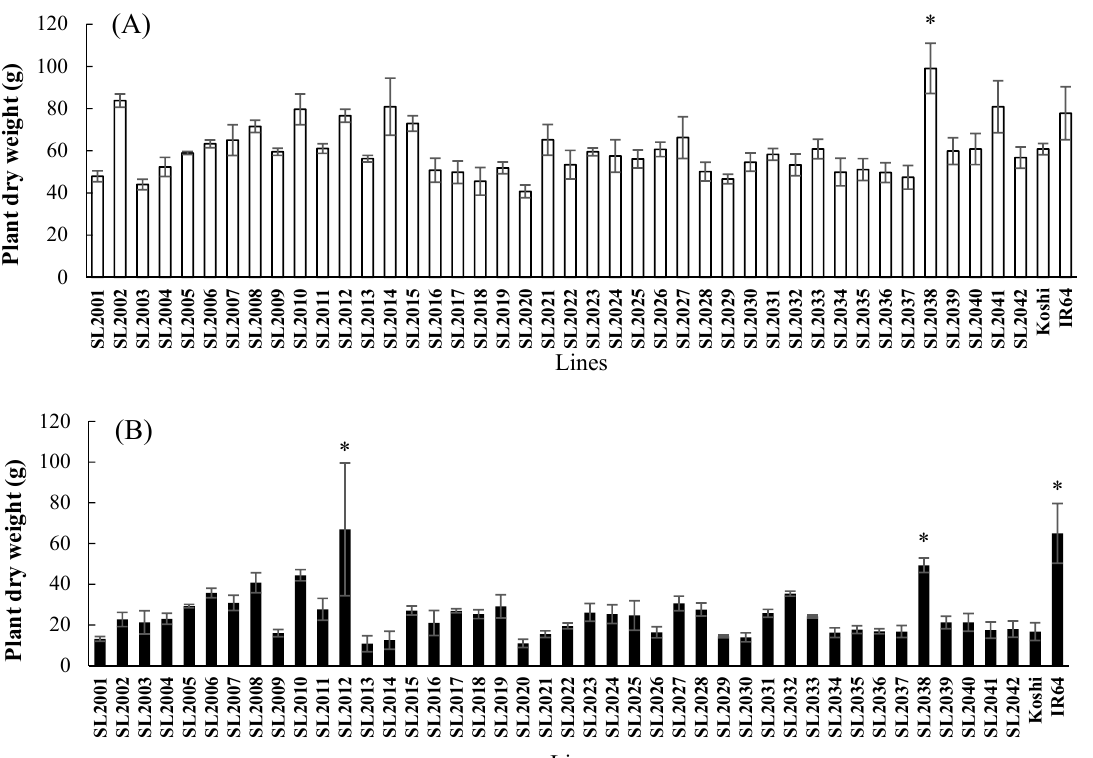
Figure 2. Plant dry weight values of 42 chromosome segment substitution lines (CSSLs) and parents under ( A ) non-stress and ( B ) salt stress conditions in 2014. Values are mean ± standard error (n = 3). * indicates a significant difference between Koshihikari and CSSL at the 5% level by Dunnett’s